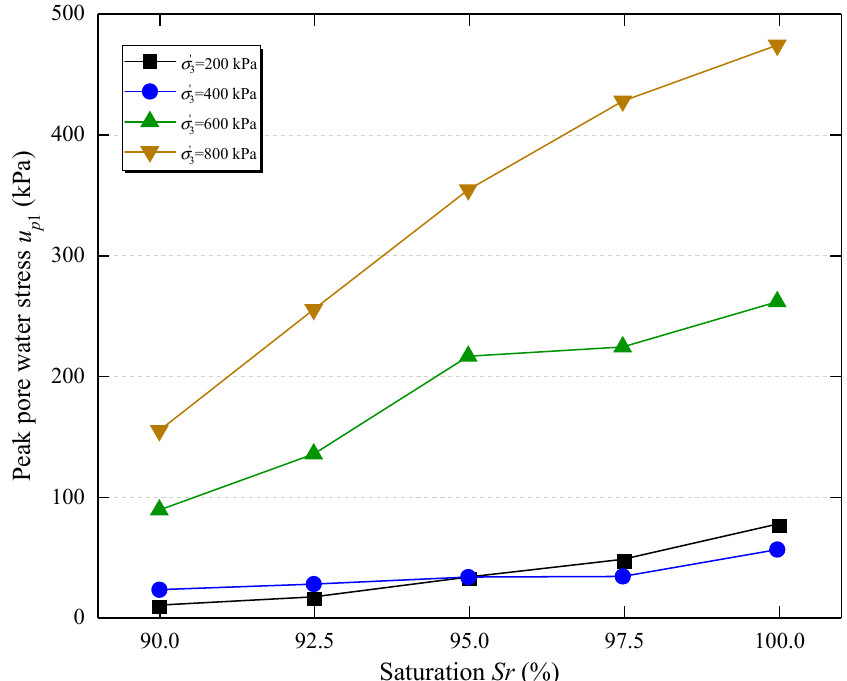
Figure 6. Relationship between peak pore water stress and saturation of coral sand.